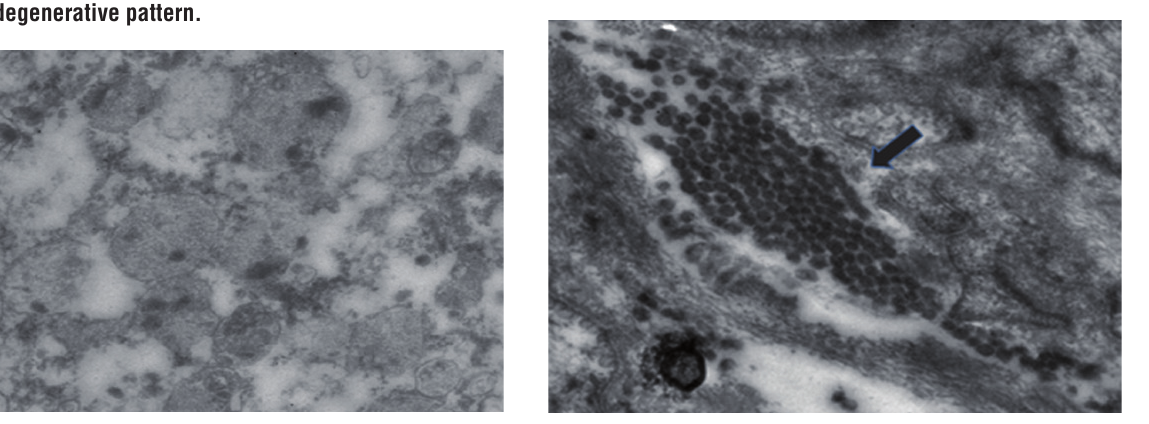
Figure 5 - Nerve hypertrophy